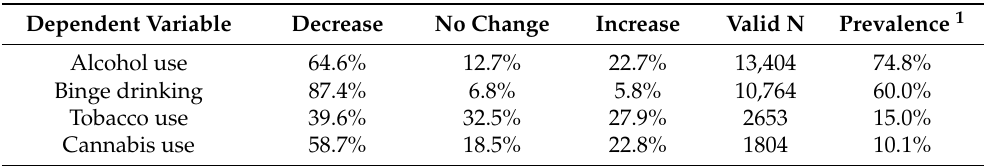
Table 2. Self-reported substance use behaviors for students with valid answers to all variables included in final